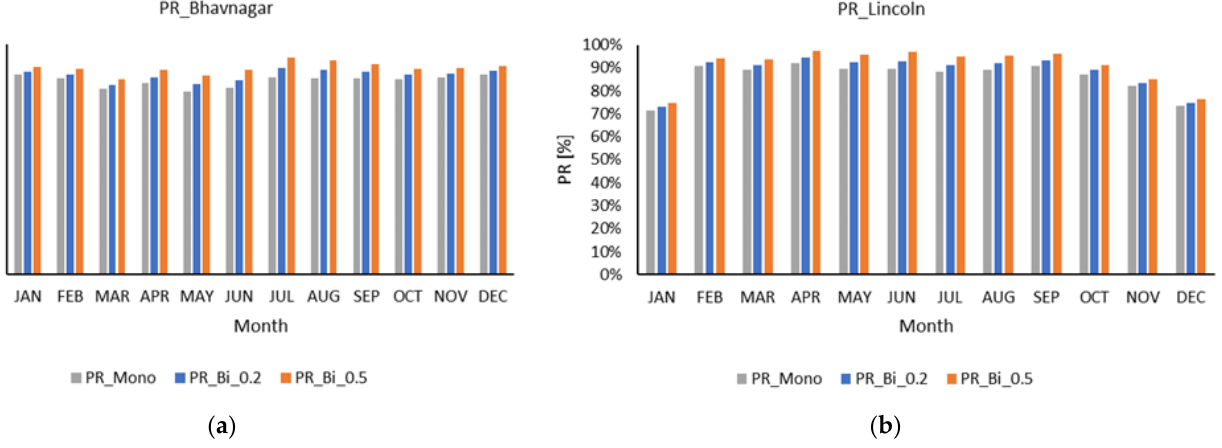
Figure 5. Monthly performance ratio of the ( a ) Lincoln Solar Farm and ( b ) Bhavnagar Solar Farm.